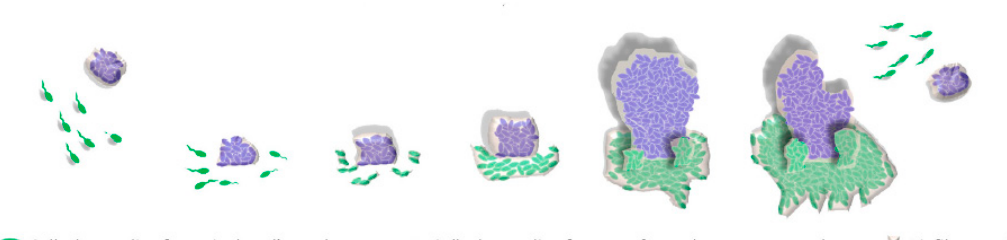
Figure 3. New model of biofilm formation. Reproduced with permission from Reference [37]. Copyright 2016, American Society for Microbiology.